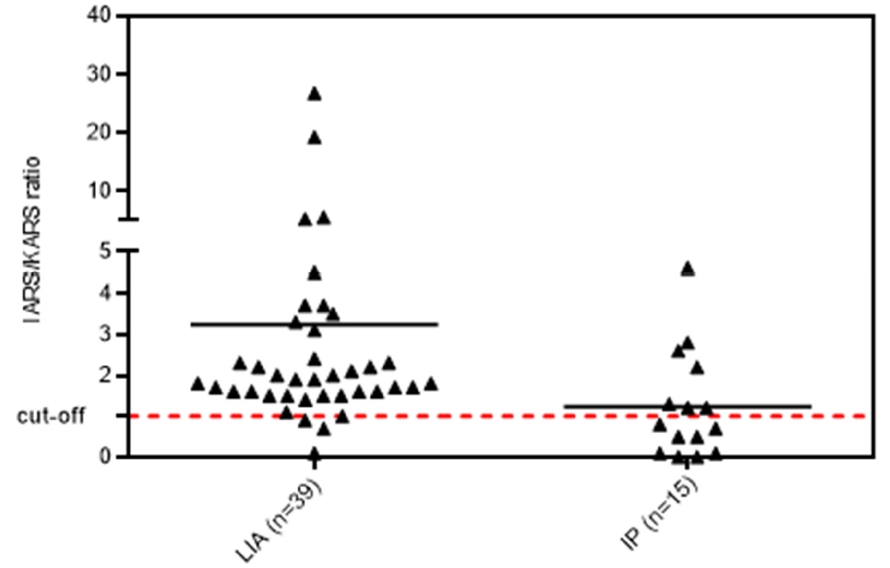
Figure 3. Ratio between anti-IARS and anti-KARS reactivity in samples selected either by line immunoassay (LIA) or immunoprecipitation (IP). Cut-off represents equal reactivity to both antigens. Legend: Samples that were selected based on LIA had significantly higher reactivity to IARS as compared to the KARS ( p = 0.003). The cut-off dotted line indicates the threshold when both antigens (IRAS and KARS) showed the same reactivity.